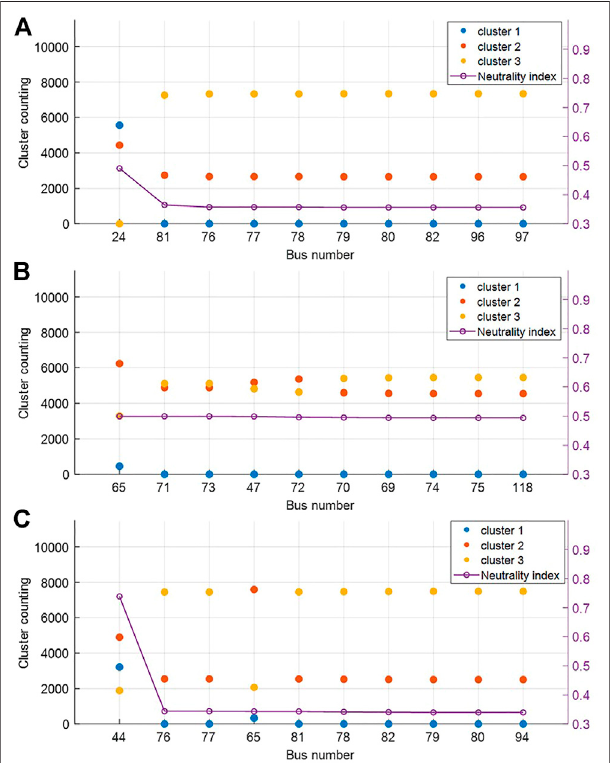
FIGURE 5 | Simulation result at (A) 20%, (B) 50%, (C) 80% penetration level.